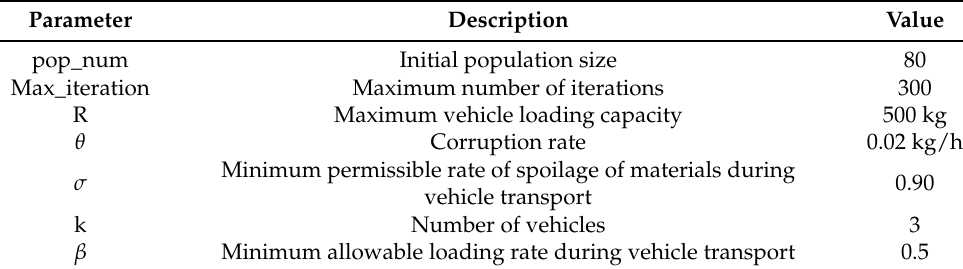
Table 8. DE-WOA parameter